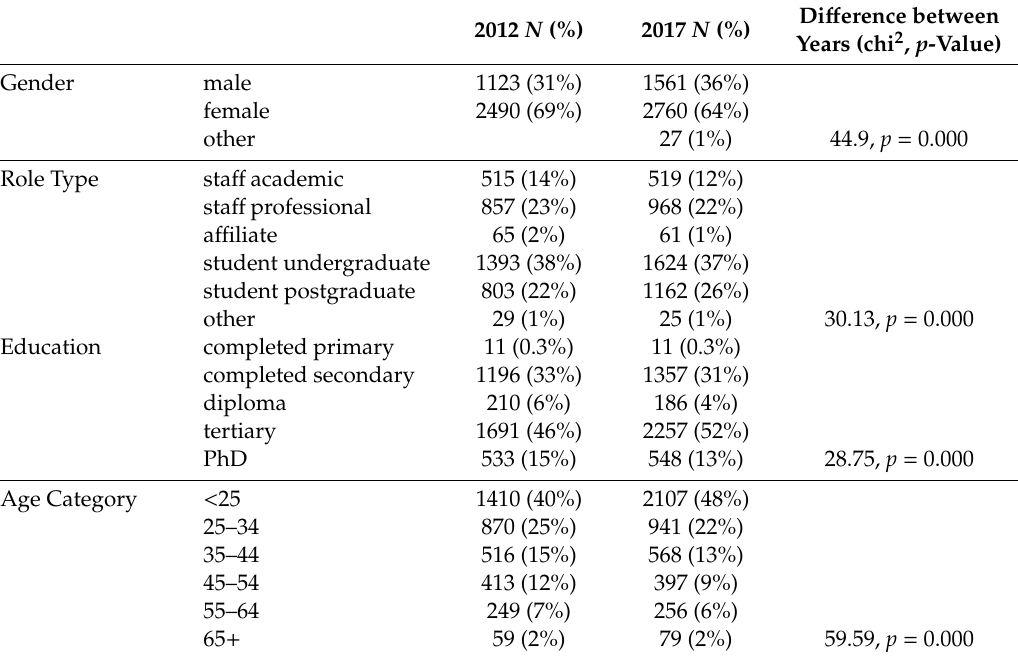
Table 1. Demographic characteristics of the study